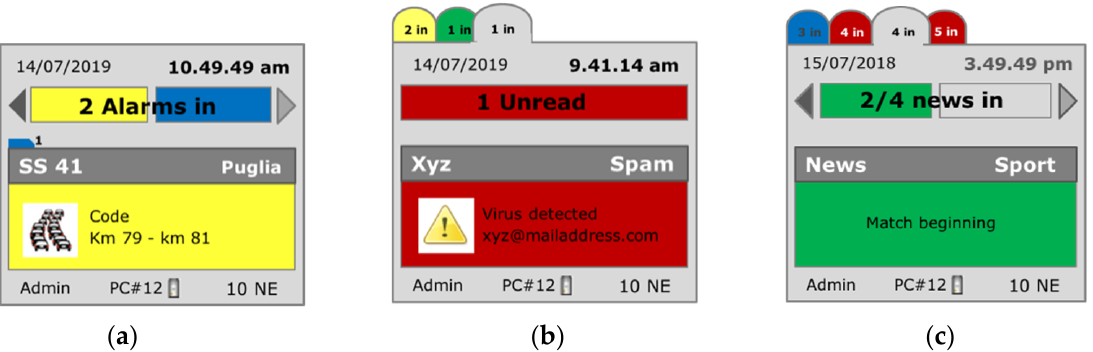
Figure 9. Handling multiple notifications: ( a ) An example of horizontal scrolling in the case of highway traffic information organized by regions; the currently displayed region is Puglia, with two incoming notifications; ( b ) an example of tabbing in the case of incoming mail; the currently displayed category is “Spam”, with one incoming notification; and ( c ) an example of a two-level structure: The currently displayed category is “News”, with four notifications scattered into a number of subcategories handled by horizontal scrolling; the currently displayed subcategory is “Sport”, with two incoming notifications.